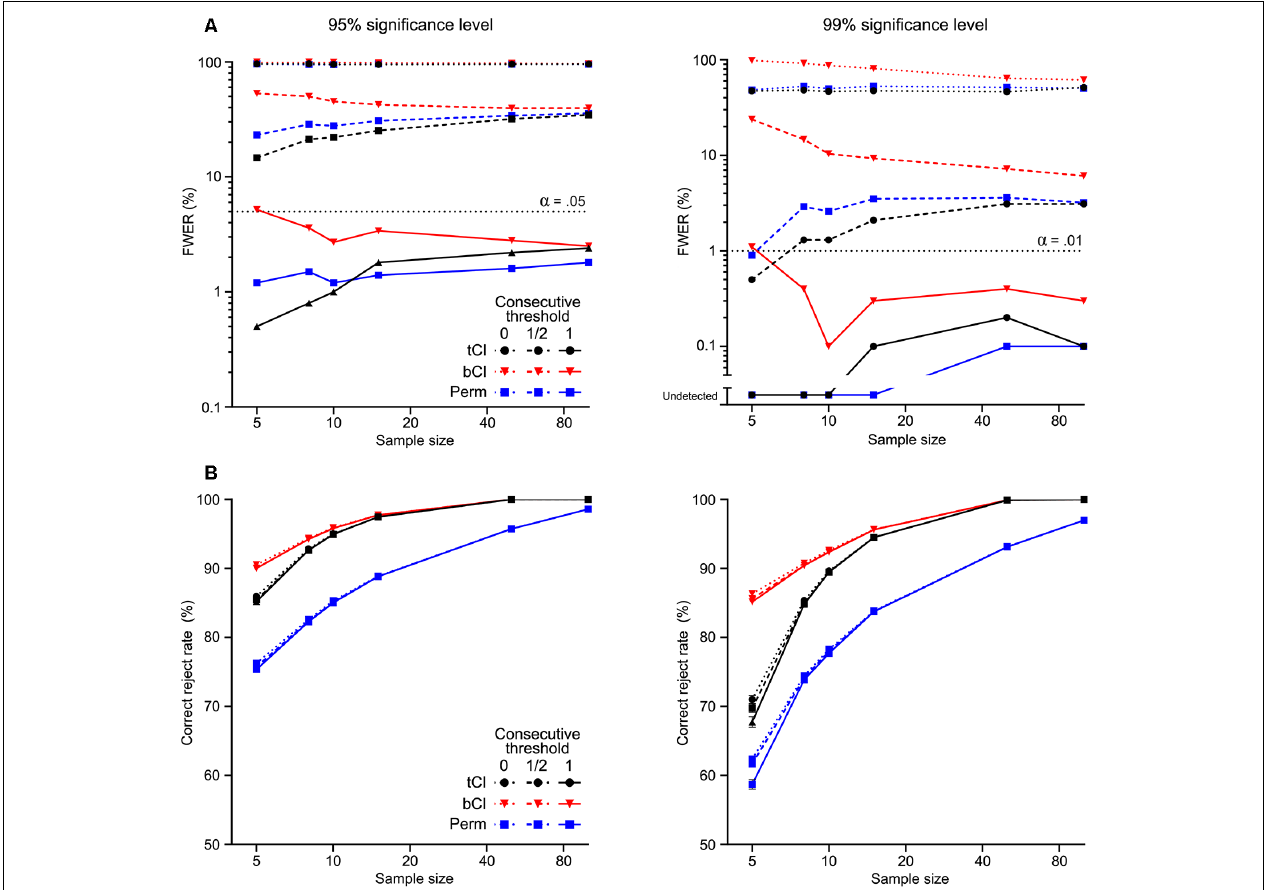
FIGURE 3 | Performance of parametric t interval [tCI (black)], bootstrapped CI [bCI (red)] and permutation test [Perm (blue)] across 1,000 Monte Carlo simulations at various sample sizes ( n = 5–100). Each simulation was tested at two significance levels [95% (left), 99% (right)]. (A) Family-wise Type I error rate (FWER) was determined as any false rejection of the null across the time window (i.e., detection of a “significant transient” from signals drawn from the null population). Each method had extremely high false-positive rates without a consecutive significance threshold (=0), regardless of the significance level. Use of a consecutive threshold substantially reduced FWER; a threshold set at the low-pass frequency (=1) reduced FWER to at or below nominal rates ( α ). (B) Correct rejection rate was determined as proportion of the artificial transient that was identified as non-zero. Bootstrapped CI was the most powerful, while permutation tests were the least powerful at detecting the extent (and presence) of the transient. Consecutive thresholds did not substantially reduce power to detect this